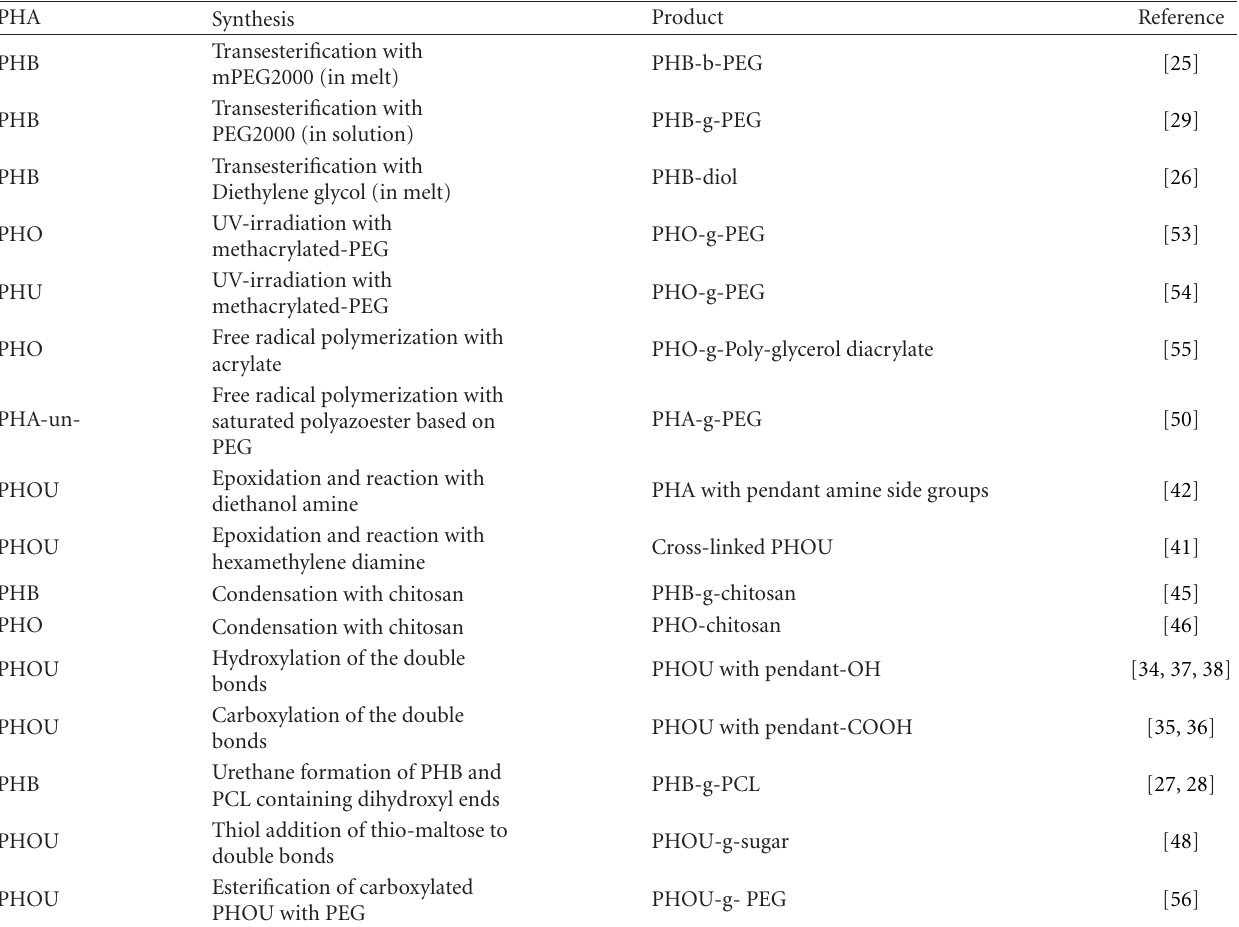
Table 2: Methods for the synthesis of the amphiphilic